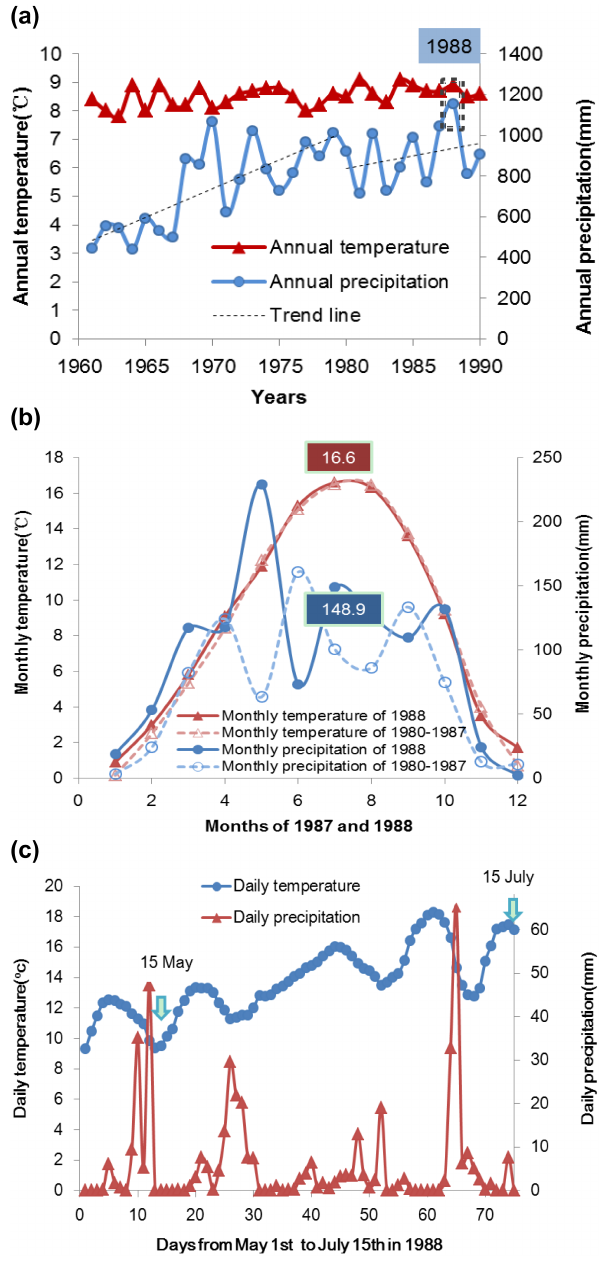
Figure 3. The temperature and precipitation of Bomê County sta- tion. (a) Annual temperature and precipitation of Bomê County from 1960 to 1990. (b) Monthly temperature and precipitation of Bomê County from 1980 to 1988. (c) Daily temperature and pre- cipitation of Bomê County before outburst in